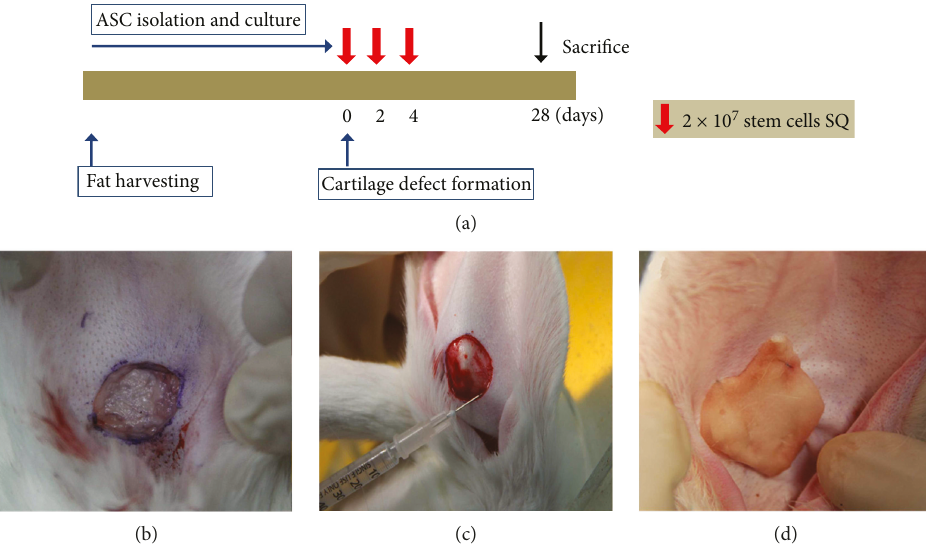
Figure 1: The experimental protocol and method. (a) Puri fi ed adipose-derived stem cells (ASCs; 2 × 10 7 cells/mL) were injected at the site of the surgically created auricular cartilage defect subcutaneously (SQ) on days 0, 2, and 4. After auricular cartilage defect was created in the rabbit (b), ASCs were injected with a 26-gauze needle at the edge of the excision site (c) and the Spongostan was attached and sutured to the defect area